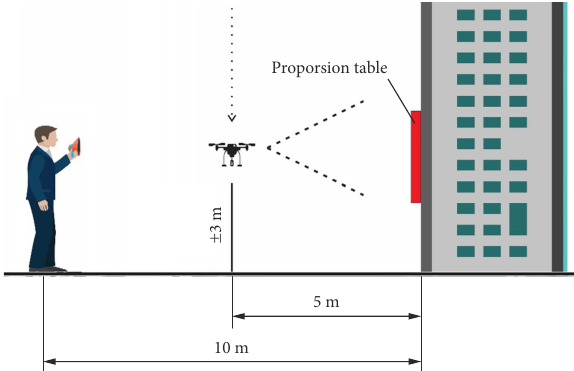
Figure 4. Verification test